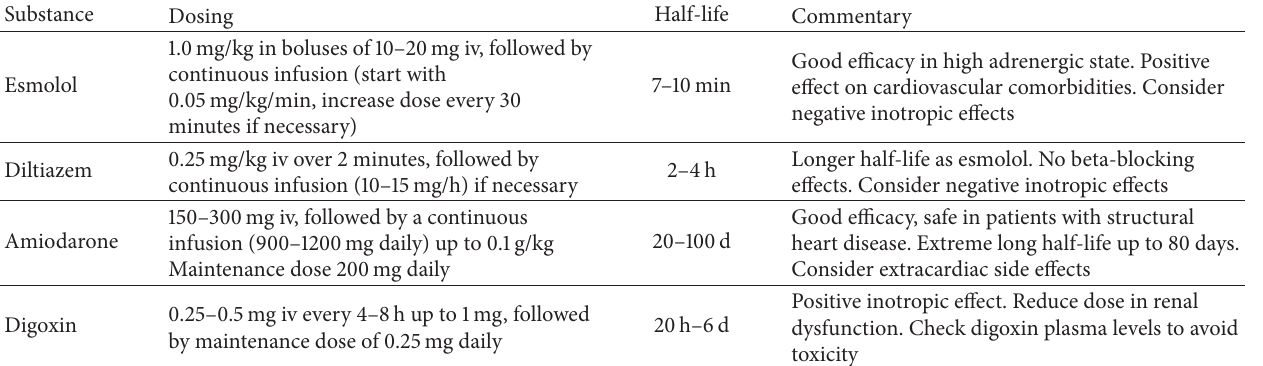
Table 2: Frequently used intravenous antiarrhythmic substances in the